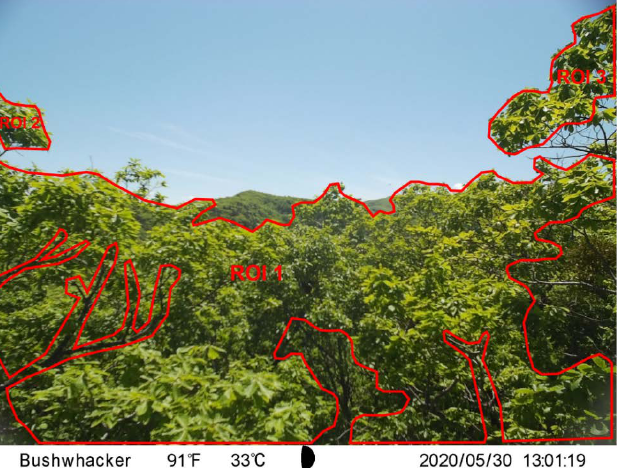
Figure 2. A field of view from the digital camera at the Mt. Jeombong site. Regions of interest (ROIs) 1–3 are indicated in